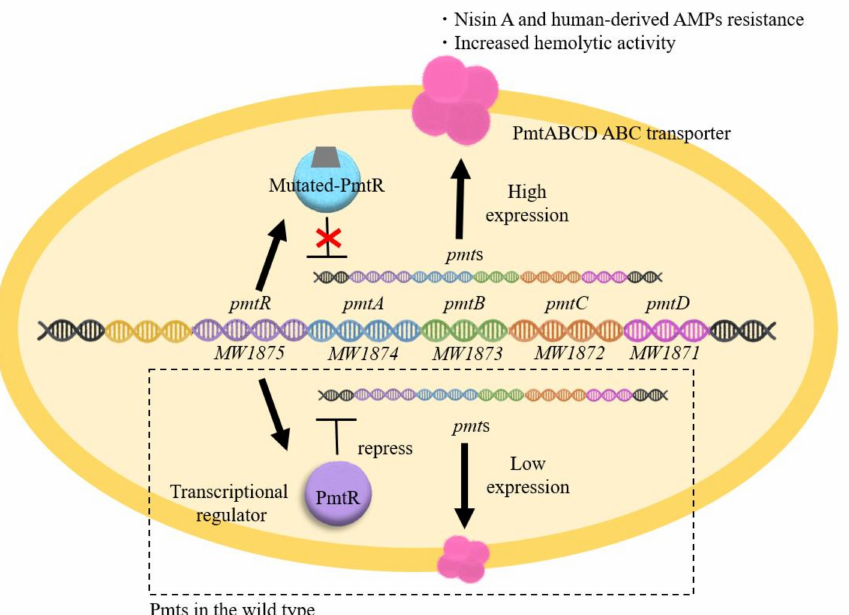
Figure 5. Mechanism underlying the high nisin A resistance of the PmtR mutant. In the MW2 strain, PmtRABCD expression was low (lower side) because PmtR negatively regulates pmtRABCD expression. In the PmtR mutation strains, mutations in PmtR result in high expression of pmtRABCD (upper side). As a result, high nisin A resistance and an increase in haemolysis are